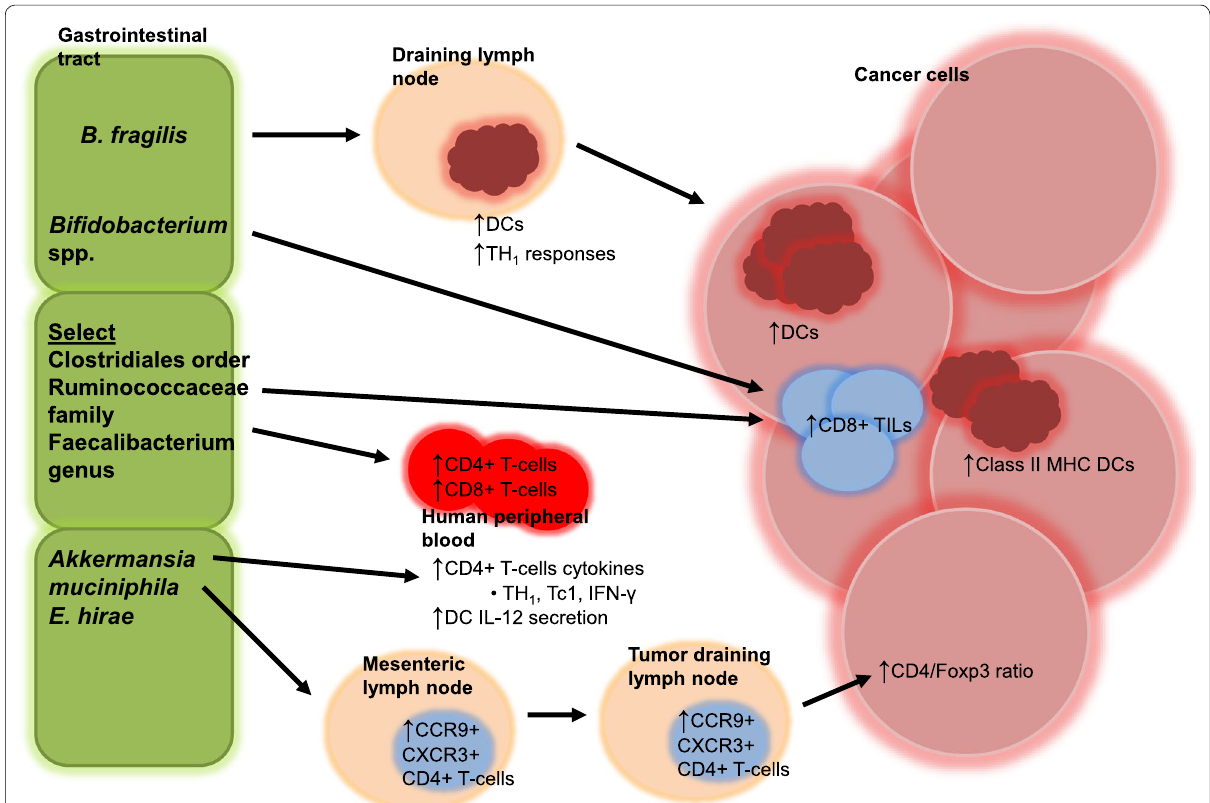
Fig. 2 Proposed immunomodulatory mechanisms of commensal bacteria on anticancer efficacy of immune checkpoint inhibitors in animal models and patients. Oral gavage of B. fragilis in germ‑free mice has been shown to induce T helper 1 (TH 1 ) immune responses in tumor‑draining lymph nodes and maturation of dendritic cells (DCs) in responders to cytotoxic T‑lymphocyte associated protein 4 (CTLA‑4) blockade. Oral gavage of Bifidobacterium spp. in mice was shown to increase accumulation of antigen‑specific CD8 + tumor‑infiltrating lymphocytes (TILs) and major histocompatibility complex (MHC) Class II DCs in responders to programmed death ligand 1 (PD‑L1) blockade. Human responders to programmed cell death protein 1 receptor (PD‑1) blockade had significant positive correlations between CD8 peripheral blood and abundance of select members of the Clostridiales order, Ruminococcaceae family, and Faecalibacterium genus. Oral gavage of Akkermansia muciniphila and E. hirae was associated with increased central memory CD4 chemokine receptor CCR9 and/or the TH 1 ‑associated chemokine receptor CXCR3 in mesenteric and tumor draining lymph nodes as well as increased CD4/Foxp3 ratios in tumors of mice cotreated with anti‑PD‑1 therapy. In human peripheral blood, secretion of cytokines by CD4 including TH 1 , Tc1, and interferon‑γ (IFN‑γ) and bone marrow‑derived DCs including IL‑12 were associated with response to PD‑1 blockade and reactivity against A. muciniphila and E. hirae (for